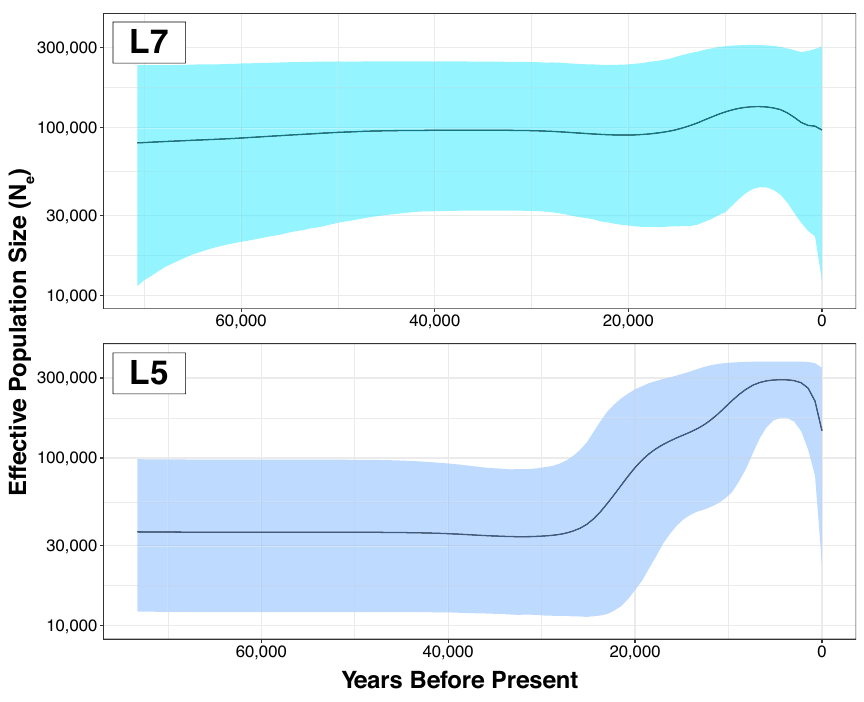
Figure 3. Bayesian Skyline Plot. Mean N e as a function of coalescent event probability is shown through time for clades L7 and L5, shaded by upper and lower 95% HPD